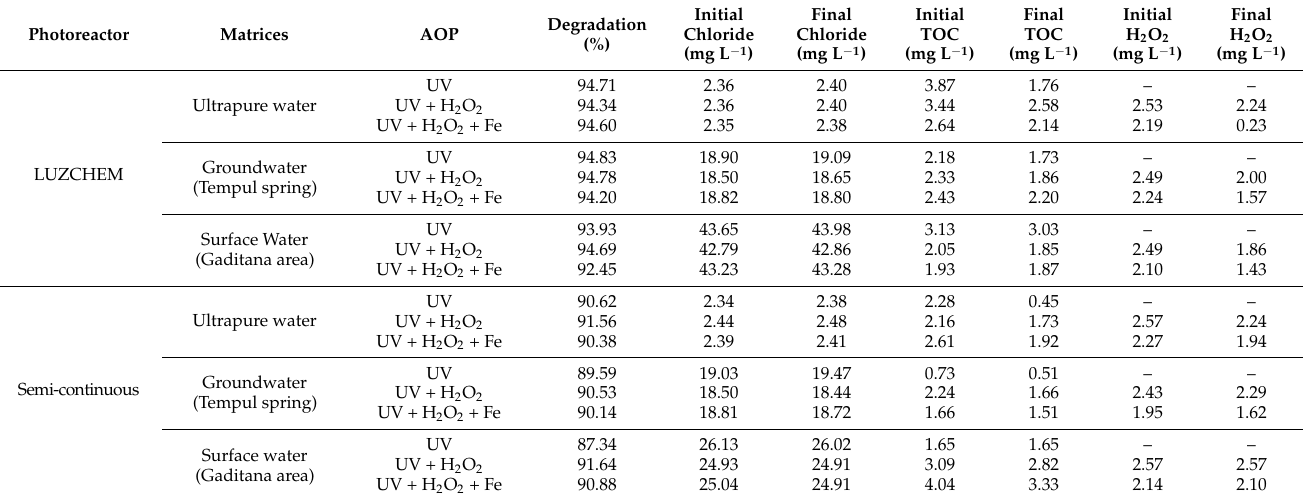
Table 4. Evolution of the degradation percentages and chloride ions, TOC and H 2 O 2 consumption in the oxidation processes applied for the LUZCHEM and semi-continuous reactors for the three matrices studied.